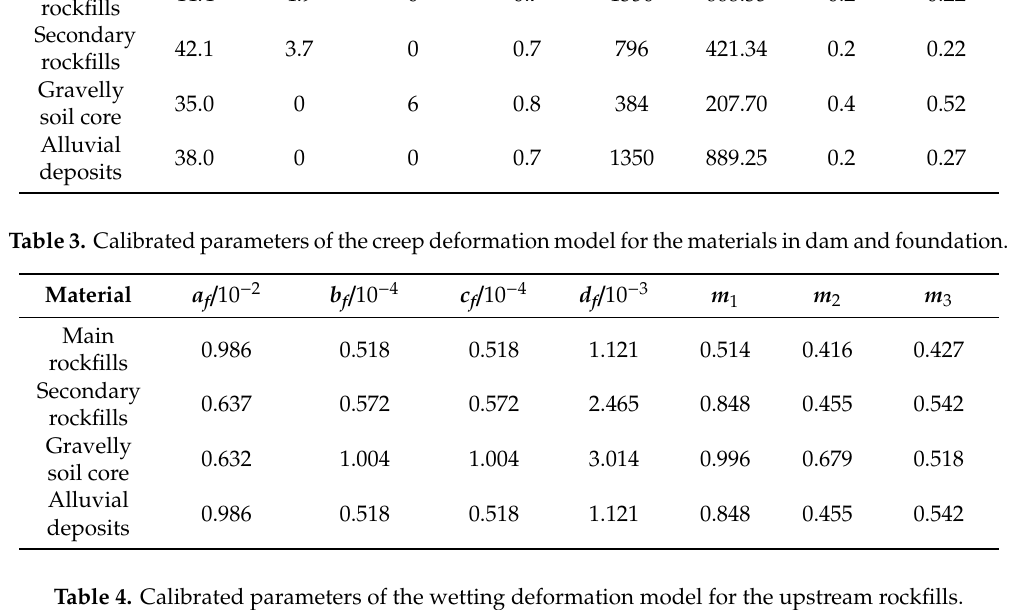
Table 3. Calibrated parameters of the creep deformation model for the materials in dam and foundation.